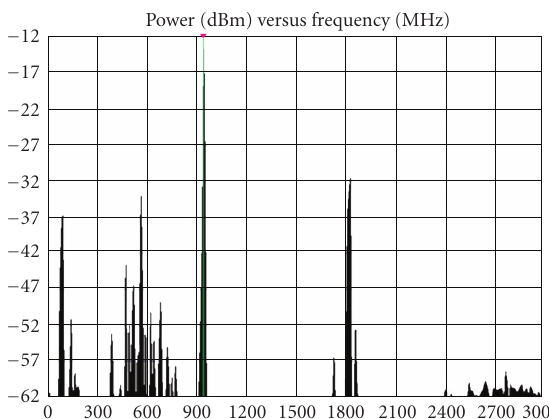
Figure 2: RF air signal Spectrum at a city location (100KHz to 3GHz).